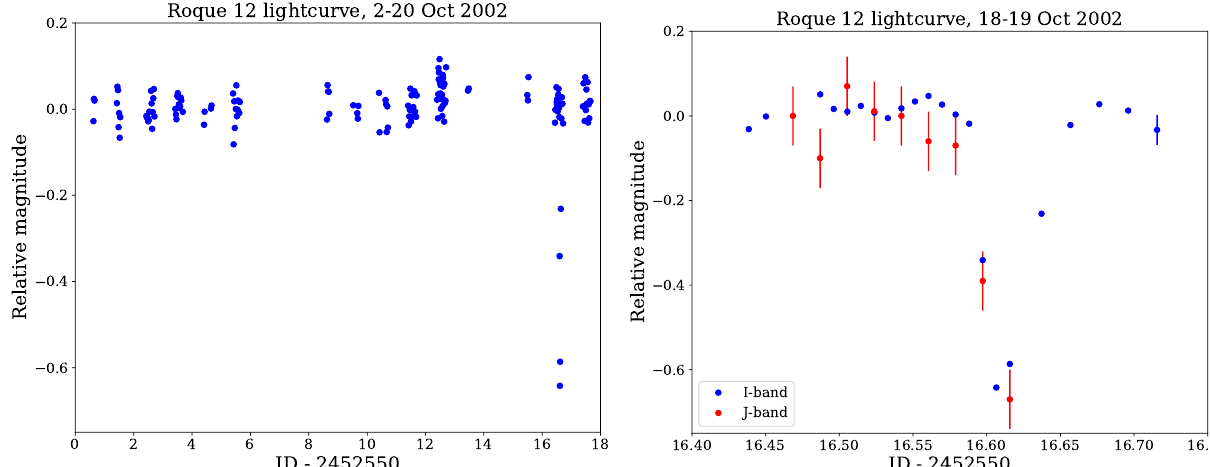
Fig. 2.— Left: I-band lightcurve for R12 for Oct 2-20 2002, observed with the 1.23m telescope on Calar Alto. The eclipse is clearly detected at t = 16 . 6 d. Right: I- and J-band lightcurve for the night Oct 18-19 2002, observed with the 1.23m and 2.2m telescopes on Calar Alto. Typical errorbars are indicated. Within the errors, the eclipse depth is the same in the two bands.